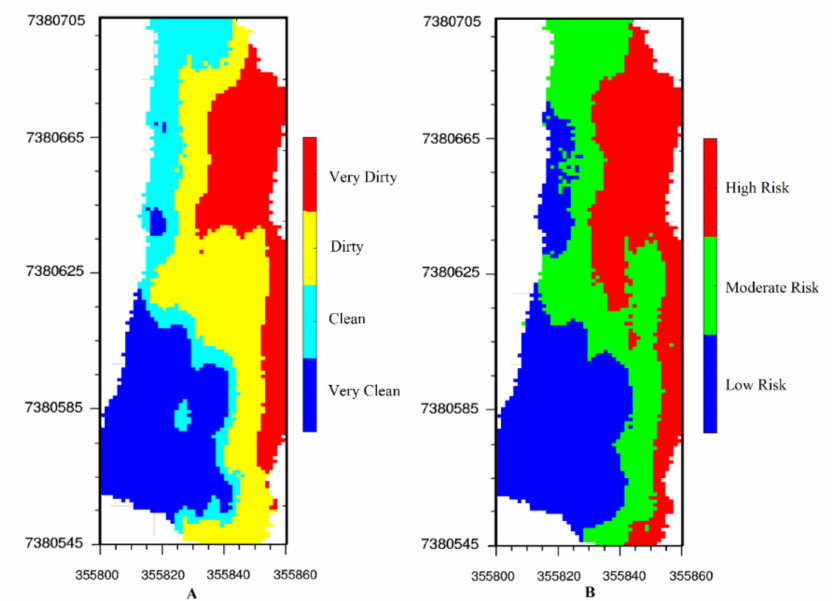
Figure 9. Classifying the beach according to ( A ) the level of contamination by cigarette butts ( B ) the risk of exposure to the sharp